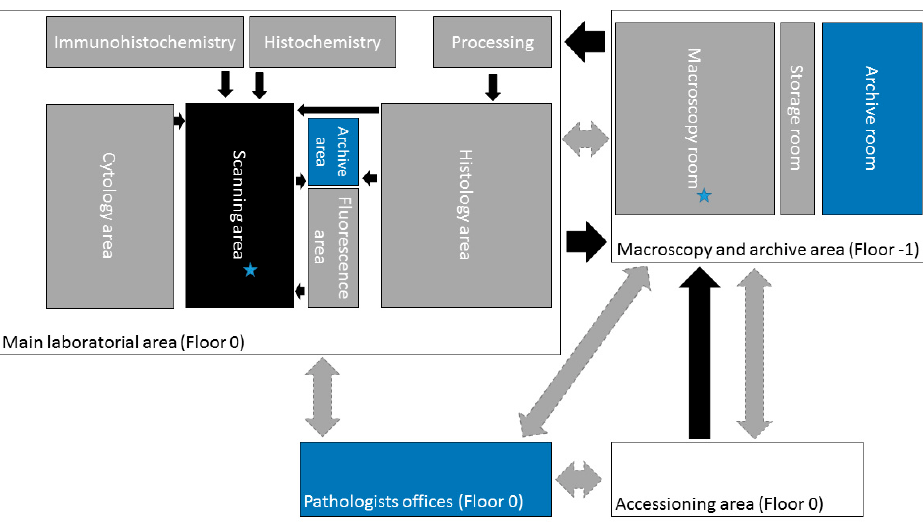
Figure 2. Schematic representation of the laboratory organization. The gray areas represent pre- scanner workstations, the black area represents the scanner workstation, and the blue areas represent the post-scanner segments. The archive area corresponds to a transitory paraffin block archive. The stars sign the bottleneck areas. The black arrows comprehend physical traffic of samples, and the gray arrows represent traffic of digital information.